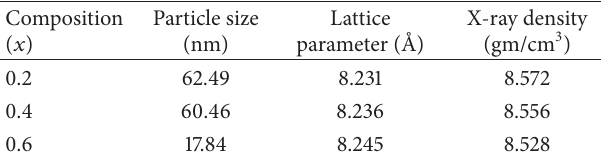
Table 1: Particle size, lattice parameter, and X-ray density of nickel cobalt zinc ferrite.